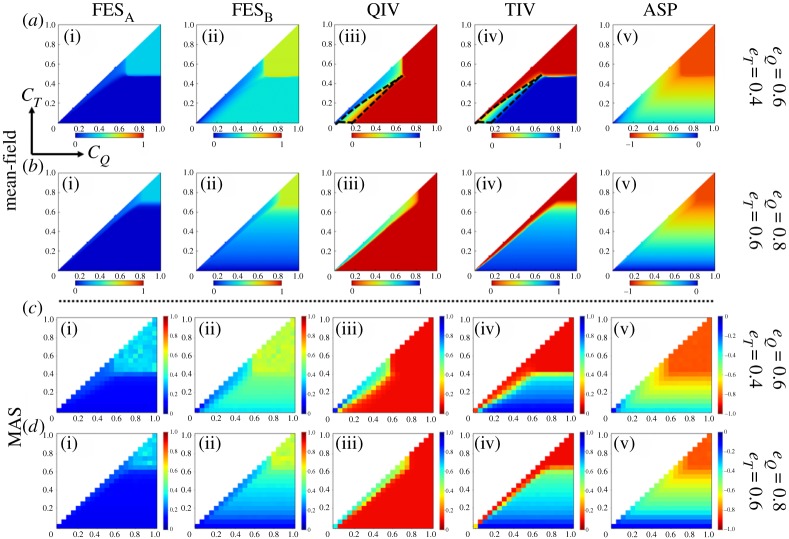
CQ versus CT (CT ≤ CQ) 2D-heatmaps with different effectiveness levels presuming mean-field (with βA = βB = 0.5, IA(0) = 0.00001, IB(0) = 0.00002) and multi-agent simulation (MAS) approach (in well-mixed population). Chronologically each column represents the final epidemic size for influenza A (FESA), the final epidemic size for influenza B (FESB), fraction of QIV vaccinees, fraction of TIV vaccinees and the average social payoff (ASP). Clearly, the infection due to influenza B is dominating for the case, βA = βB. The fraction of TIV vaccinees is seen to prevail for certain regime as long as CT is below some threshold levels, however, QIV vaccinees are predominant whenever CQ and CT are comparable. Results from MAS approach show an overall similar tendency to that of mean-field approach. The MAS approach presumes 10 000 agents with IA(0) = 2 agents, IB(0) = 4 agents, βA = βB = 5.19957 × 10−5, γA = γB = 0.2, and takes ensemble average of 100 realizations. (Online version in colour.)